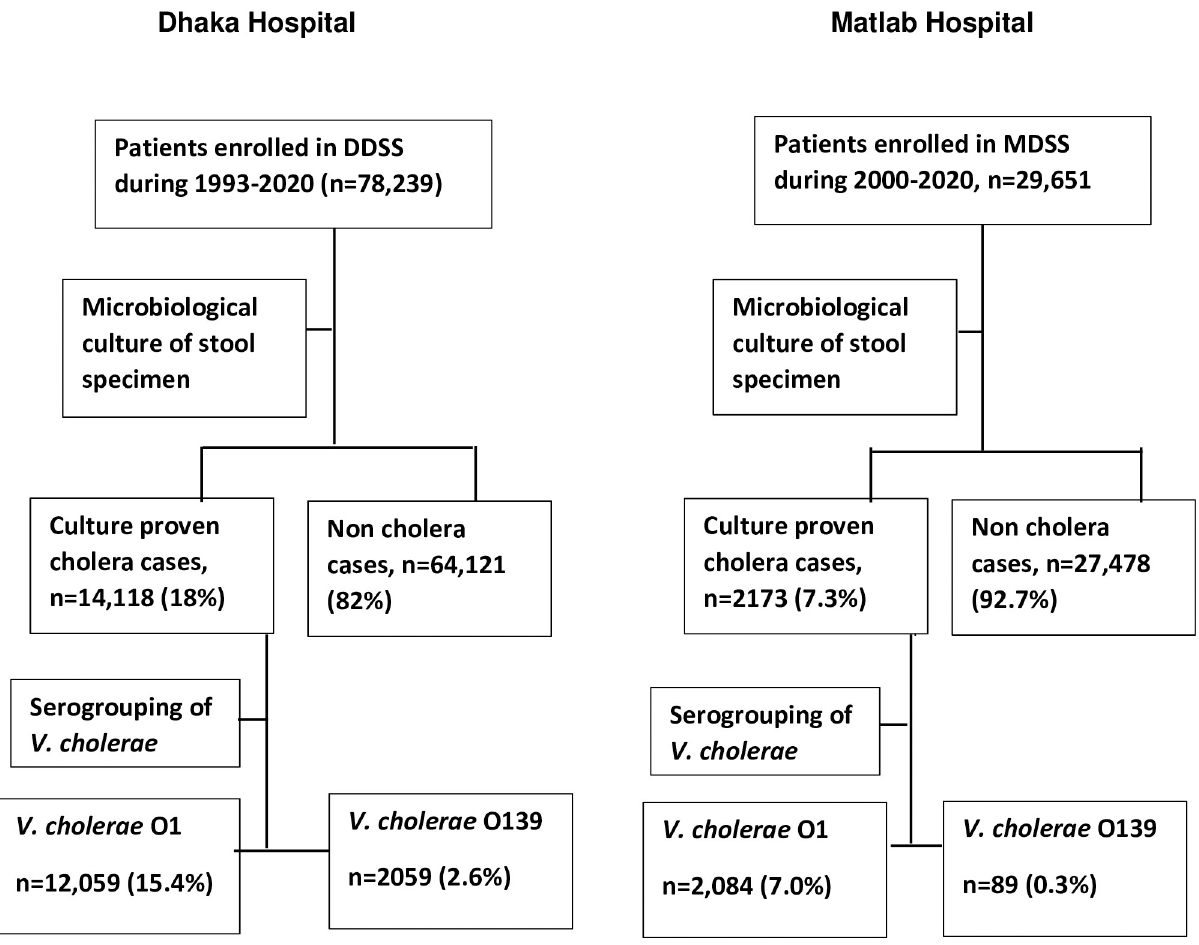
Fig 1. Study flowchart summarizing the selection processes of the